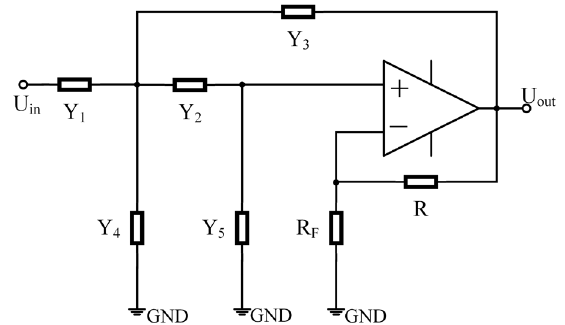
Figure 3. Sallen–Key second-order filter circuit topology.